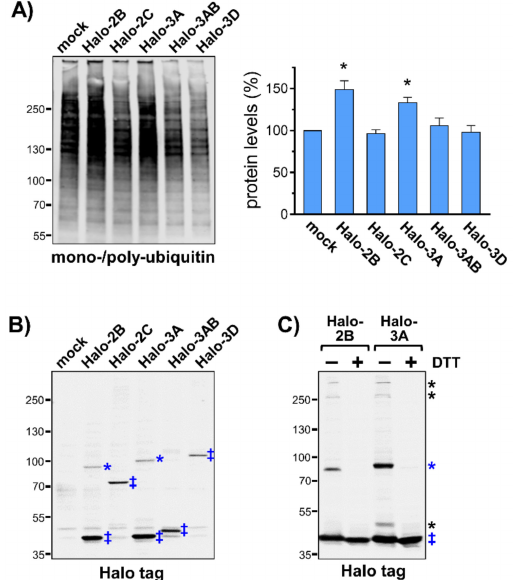
Figure 2. Accumulation of ubiquitin conjugates during ectopic expression of CVB3 proteins 2B and 3A. ( A ) HeLa cells transfected with indicated Halo-tagged CVB3 proteins for 48 h were collected